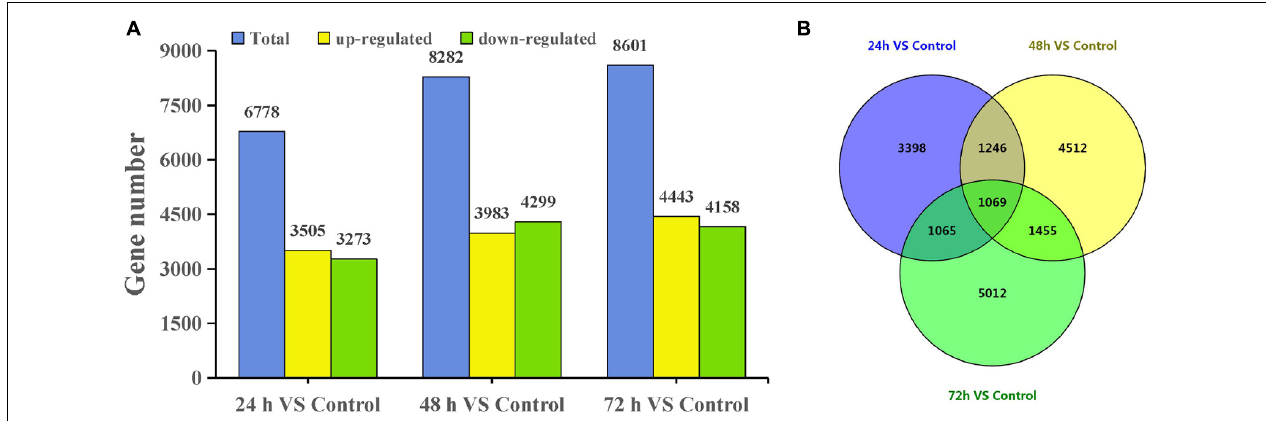
FIGURE 2 | DEGs of T. hispida under cadmium treatments. (A) Gene number analysis of DEGs between the cadmium treated transcriptomes compared with the control. (B) Venn diagrams of these DEGs.